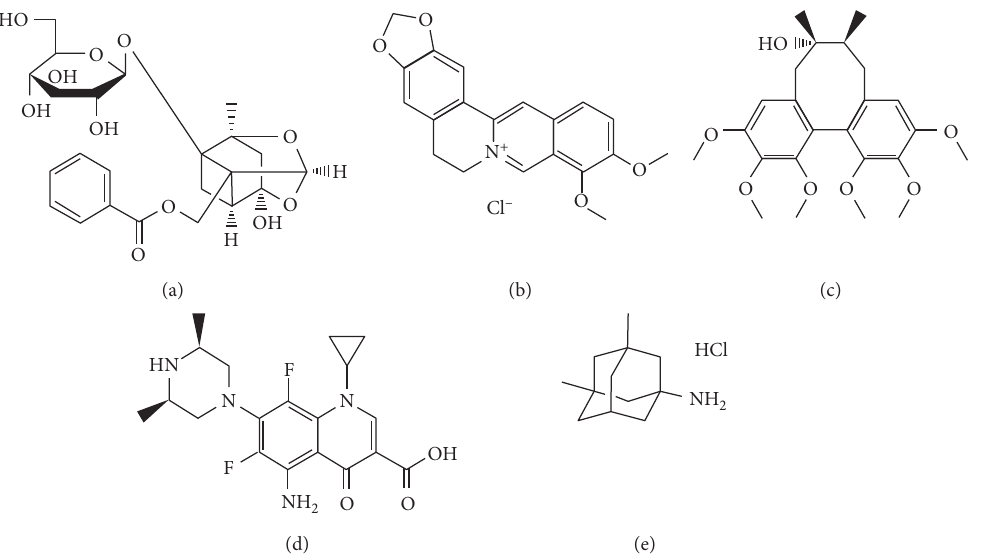
Figure 1: Chemical structures of PF (a), BBR (b), SCH (c), IS for LC-MS ((d), sparfloxacin), and IS for LC-MS/MS ((e), memantine